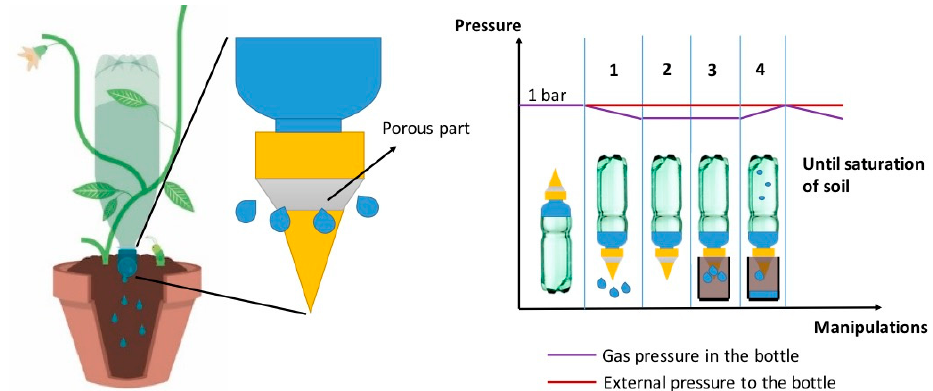
Figure 3. Simplified diagram of the operating principle of the drip watering system.